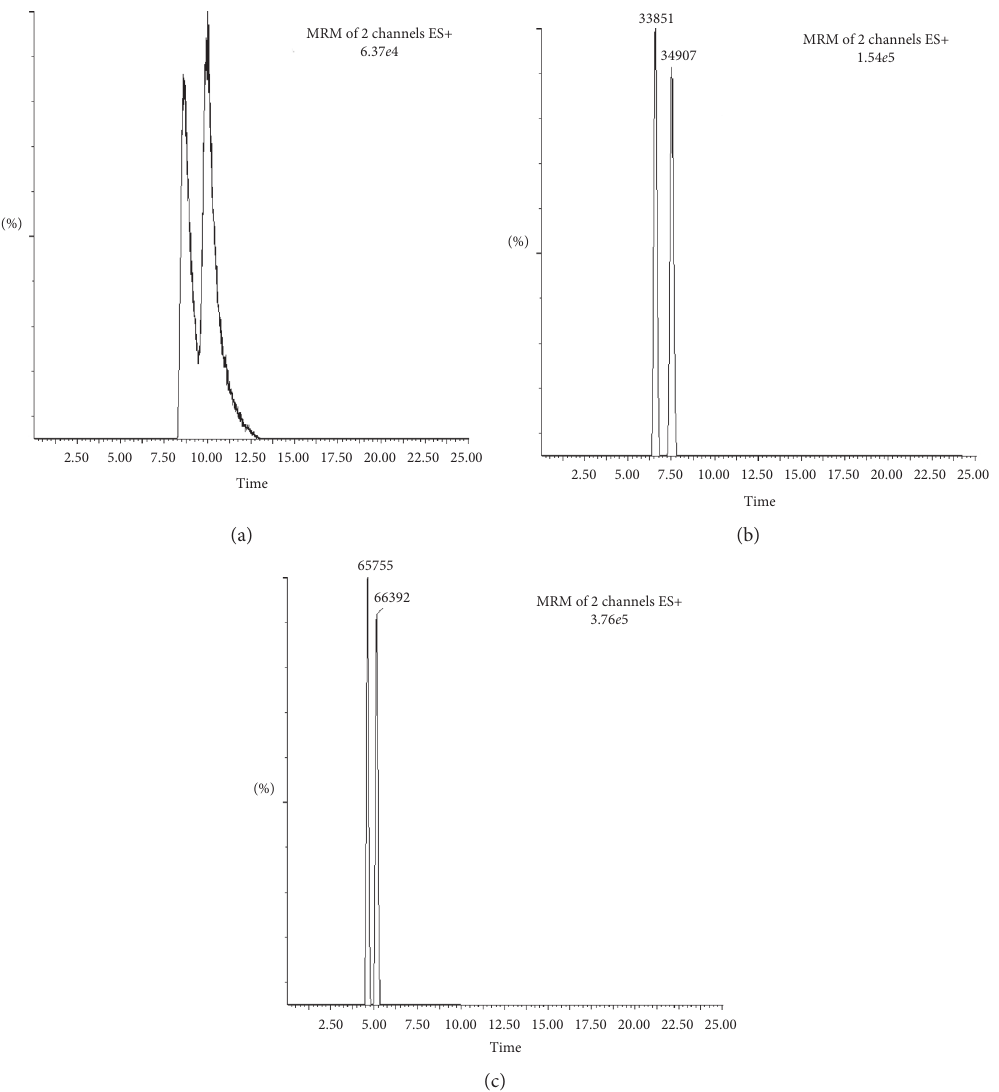
Figure 3: Effect of mobile phase composition on the separation of OME enantiomers: (a) hexane +isopropanol (80: 20) as mobile phase, (b) hexane +ethanol (80: 20), and (c) hexane +ethanol +NH 3 OH (70 :30: 0.2